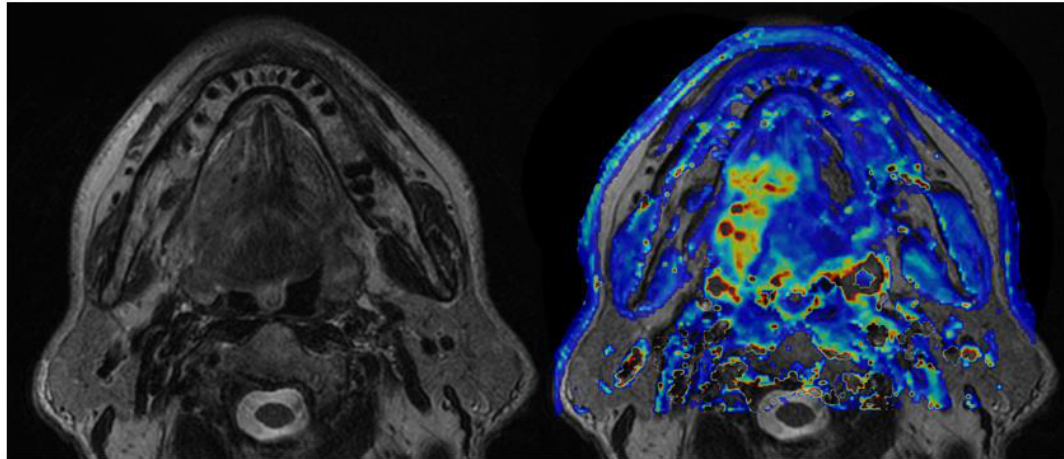
Figure 4. Top (from left to right): central section of a cheek tumor in a 68-year-old man on diffusion-weighted images obtained with increasing values: b = 0, 500, 1000, 1500 and 2000 mm 2 /s; the user-defined lesion contour is in red. Bottom (from left to right): histograms of D and K values derived from the entire tumor volume, indicating slightly restricted water molecule diffusivity and moderately increased kurtosis as well as the presence of low levels of tumor-infiltrating lymphocytes (TILs) (hematoxylin – eosin; original magnification: 20×).